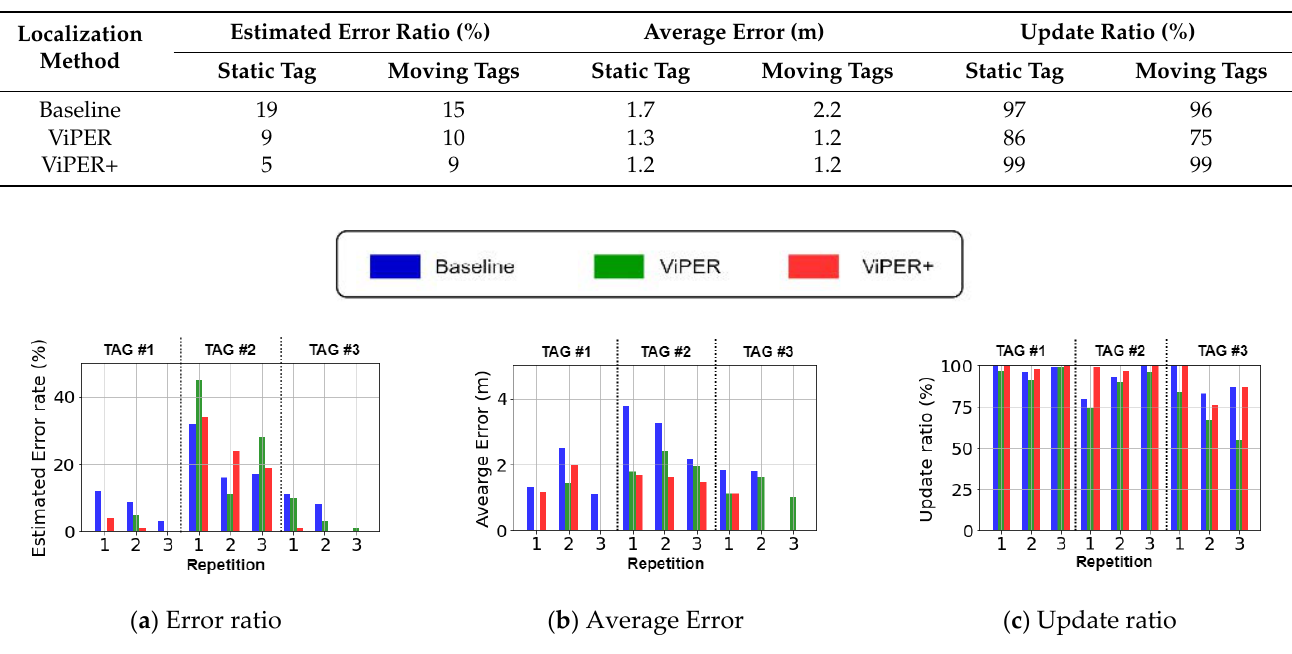
Figure 12. Worker tracking results for scenarios without blocking objects (LOS).